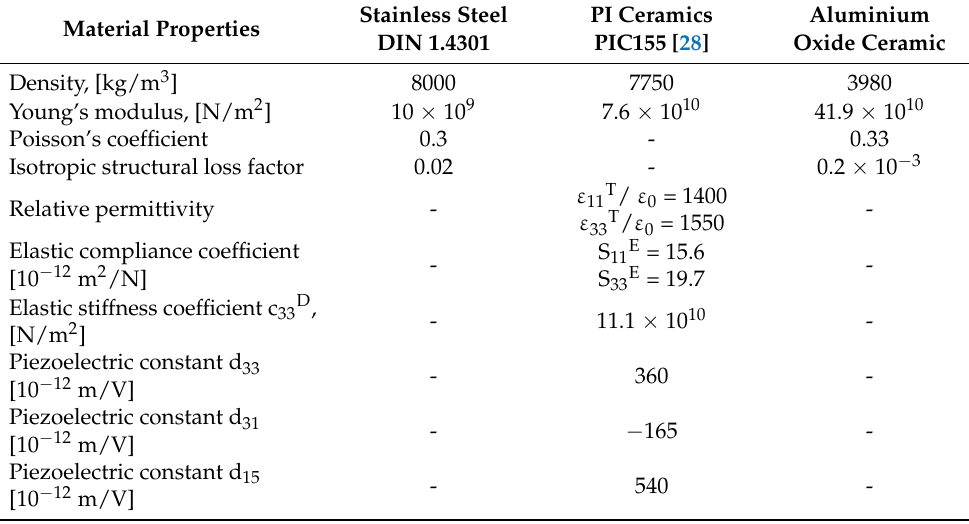
Table 3. Properties of the materials used for numerical